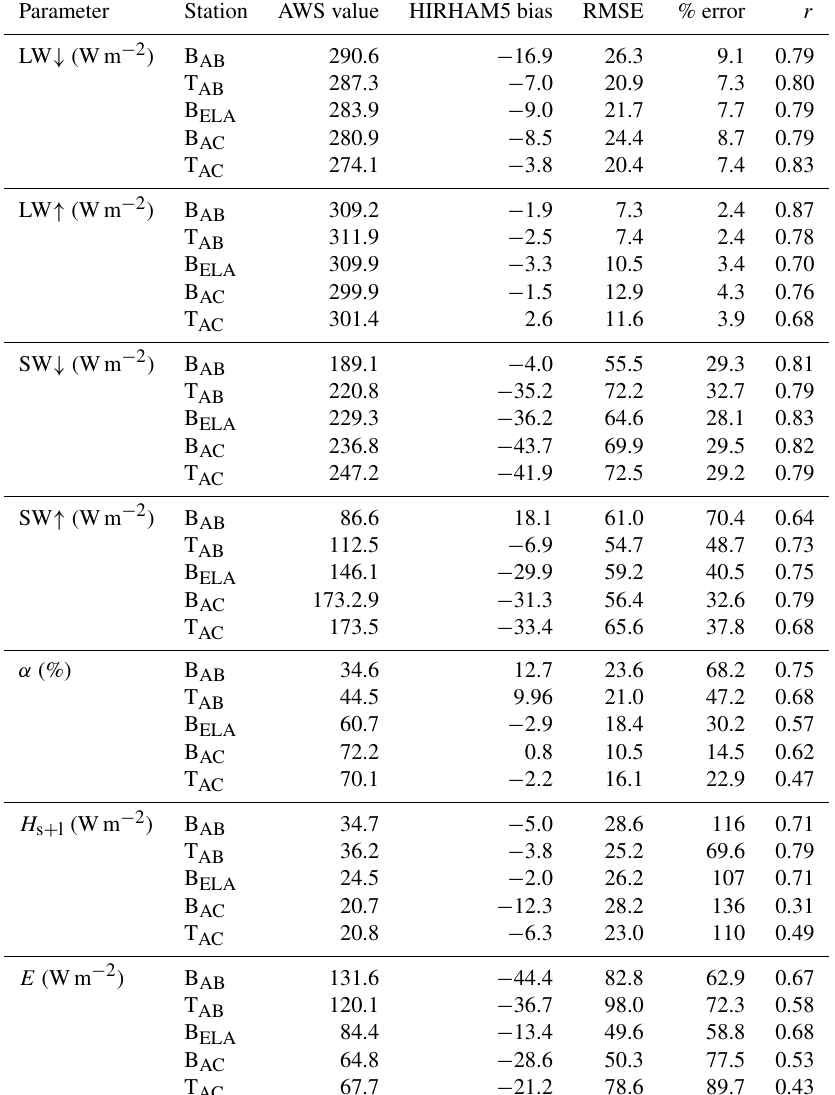
Table 3. Comparison of incoming and outgoing long- and shortwave radiation, albedo ( α ), turbulent fluxes ( H s + l ), and total energy ( E ) from HIRHAM5 simulations and AWS measurements during summer months (April–October) from the period 2001–2014. The HIRHAM5 bias (HIRHAM5-AWS), the root-mean-square error (RMSE), the percentage error, and the correlation ( r ) are shown.